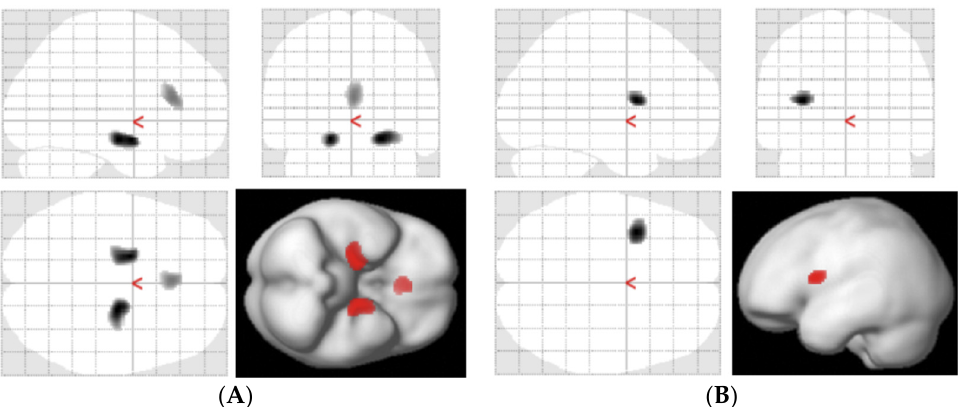
Figure 5. Mean values of regional K in (mL/min/100 g) ( A ), k 3 (×10 2 /min) ( B ), and K 1 (mL/min/100 g) ( C ) obtained by the manual ROIs method. K in of eAD (gray) in the PCC region was significantly greater than those of the frontal and parietal regions in HCs (white) (* p < 0.05). On the other hand, k 3 of eAD in the hippocampus was greater than other cortical values of HCs (* p < 0.05), particularly in the parietal region ( † p < 0.01). K1 in the hippocampus showed significant decreases for both groups ( † p < 0.01) compared with the frontal and parietal regions including PCC. SUV did not show regional differences (see Table 2).